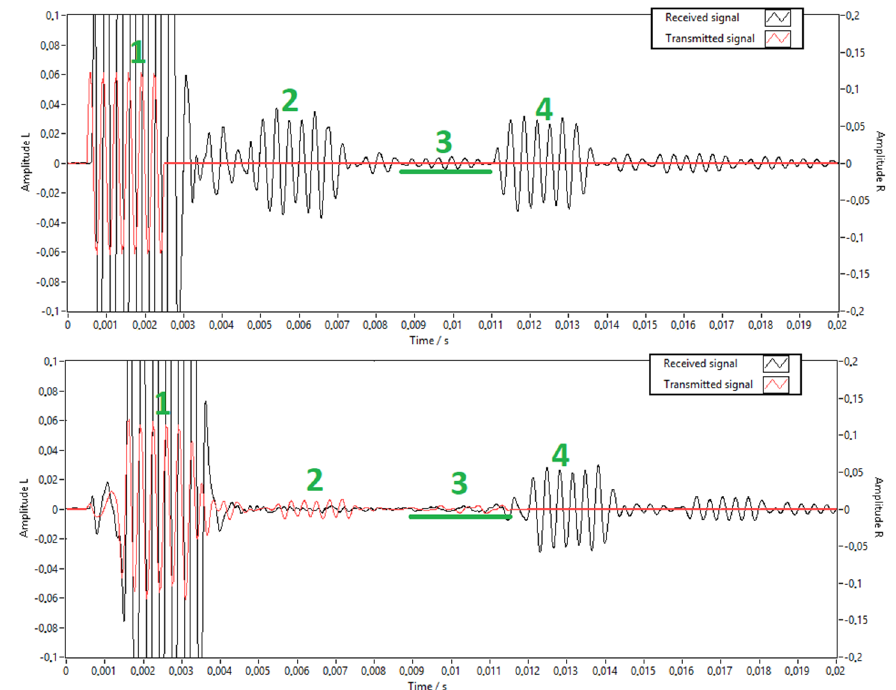
Figure 14. Comparison of returned signals before (top) and after acoustic signal cancellation (ASC) (bottom). The region where signal overlap occurs is shown by the green line. With 1 is marked direct signal from the loudspeaker, with 2 is marked returned signal from change in radius (marked in Figure 6), with 4 is marked signal from the end of the sensing end. With 3 is marked overlapped signal which is first reflected from change in radius and again from the loudspeaker.